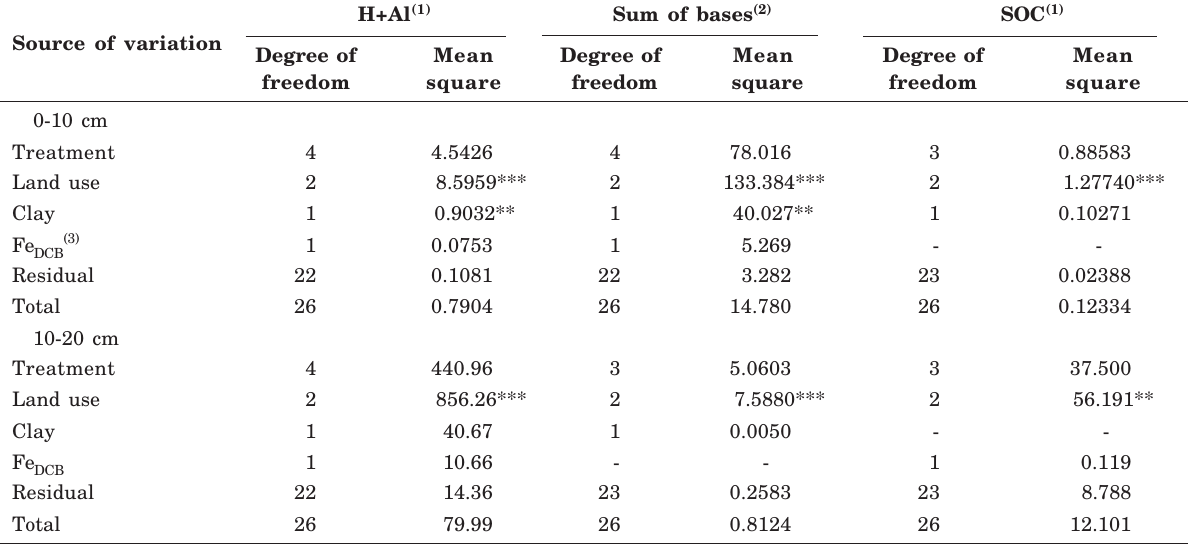
Table 3. Analysis of covariance statistics of soil potential acidity (H+Al), sum of bases and soil organic carbon (SOC) for three land uses (conventional agriculture, no-tillage and native forest)